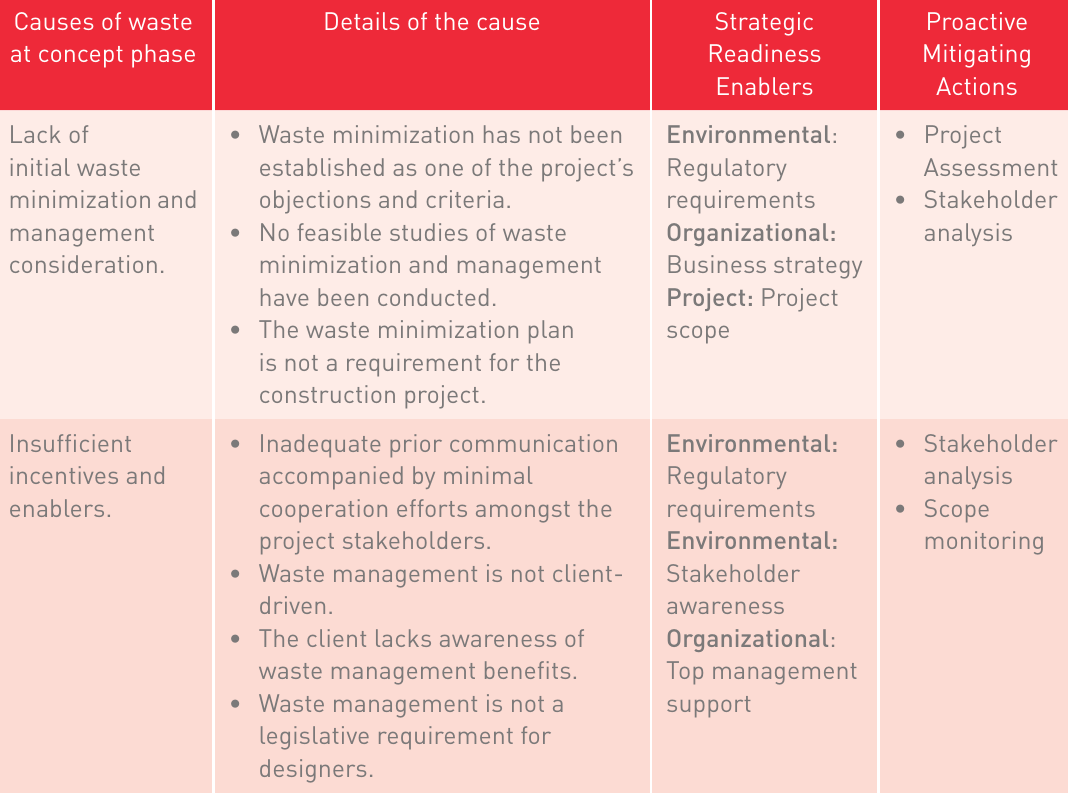
Table 4. Participants’ perceptions on waste causes during the project concept phase Causes of waste Details of the at concept phase